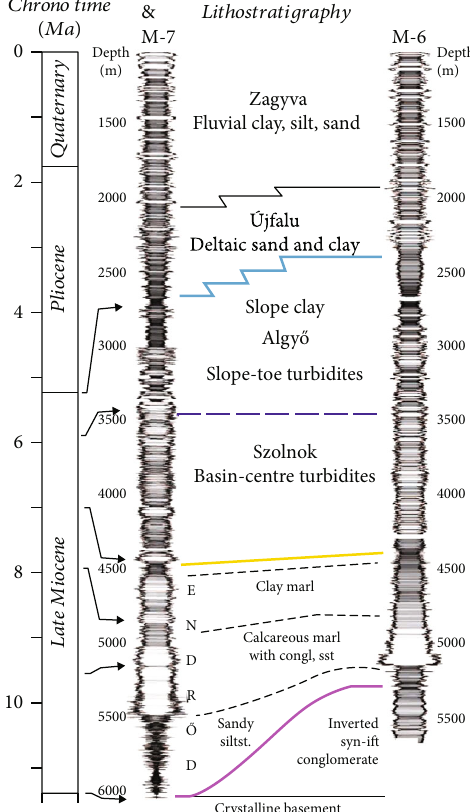
Figure 3: Chrono- and lithostratigraphy of the sedimentary rocks in the Makó Trough. The lithology is indicated by mirrored gamma logs [25,